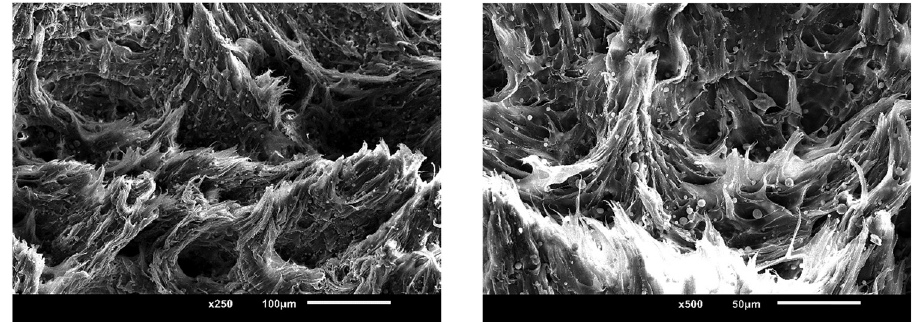
Figure 5: Tensile cross - sectional SEM images of nylon 6 - hBN composite.